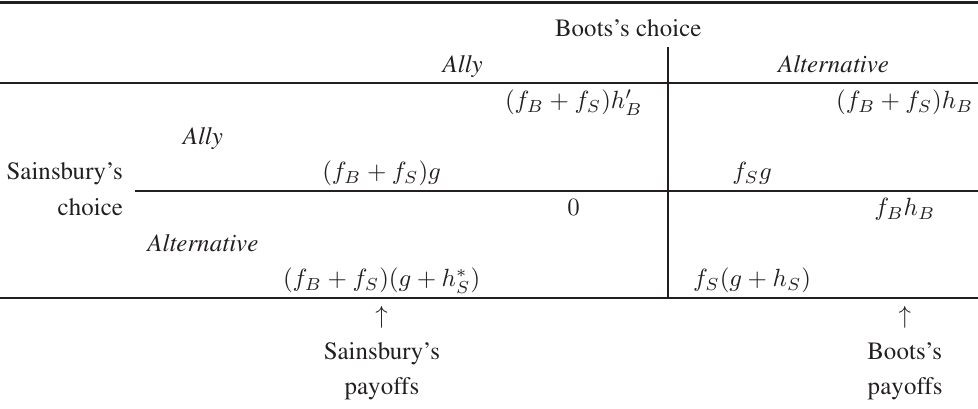
Table 1. Boots and Sainsbury’s play the Prisoners’